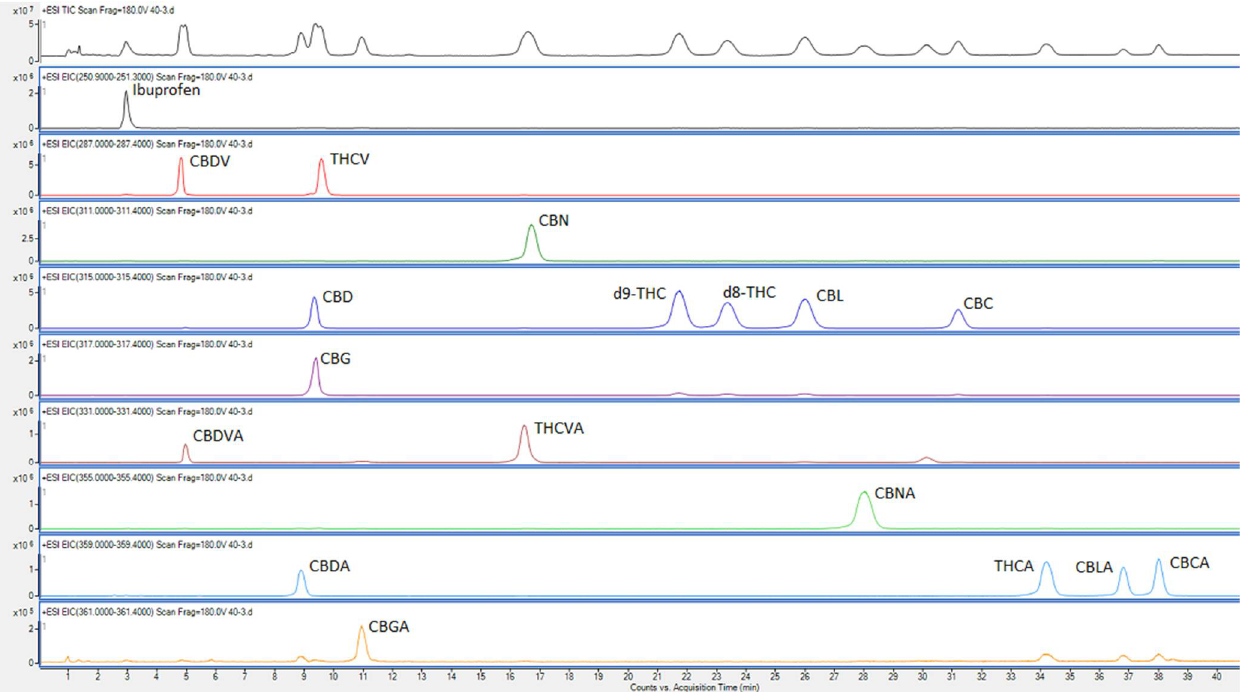
Figure 1. Chromatographic and mass spectrometric separation of Ibuprofen and 17 cannabinoids in a standard mixture. Top Chromatogram shows the total ion chromatogram and the other chromatograms are extracted at the mass of compound/s.